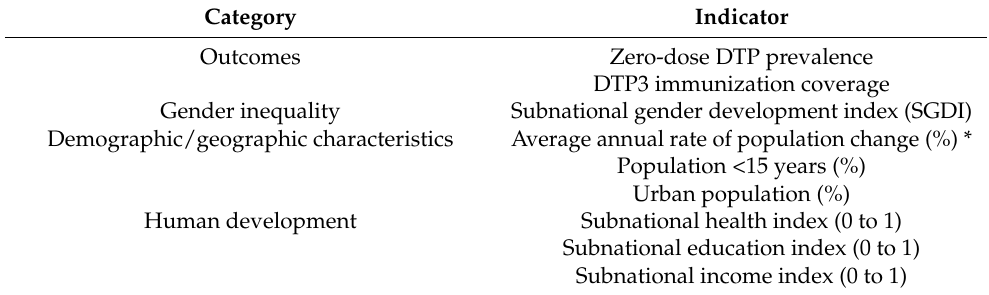
Table 1. Measures.